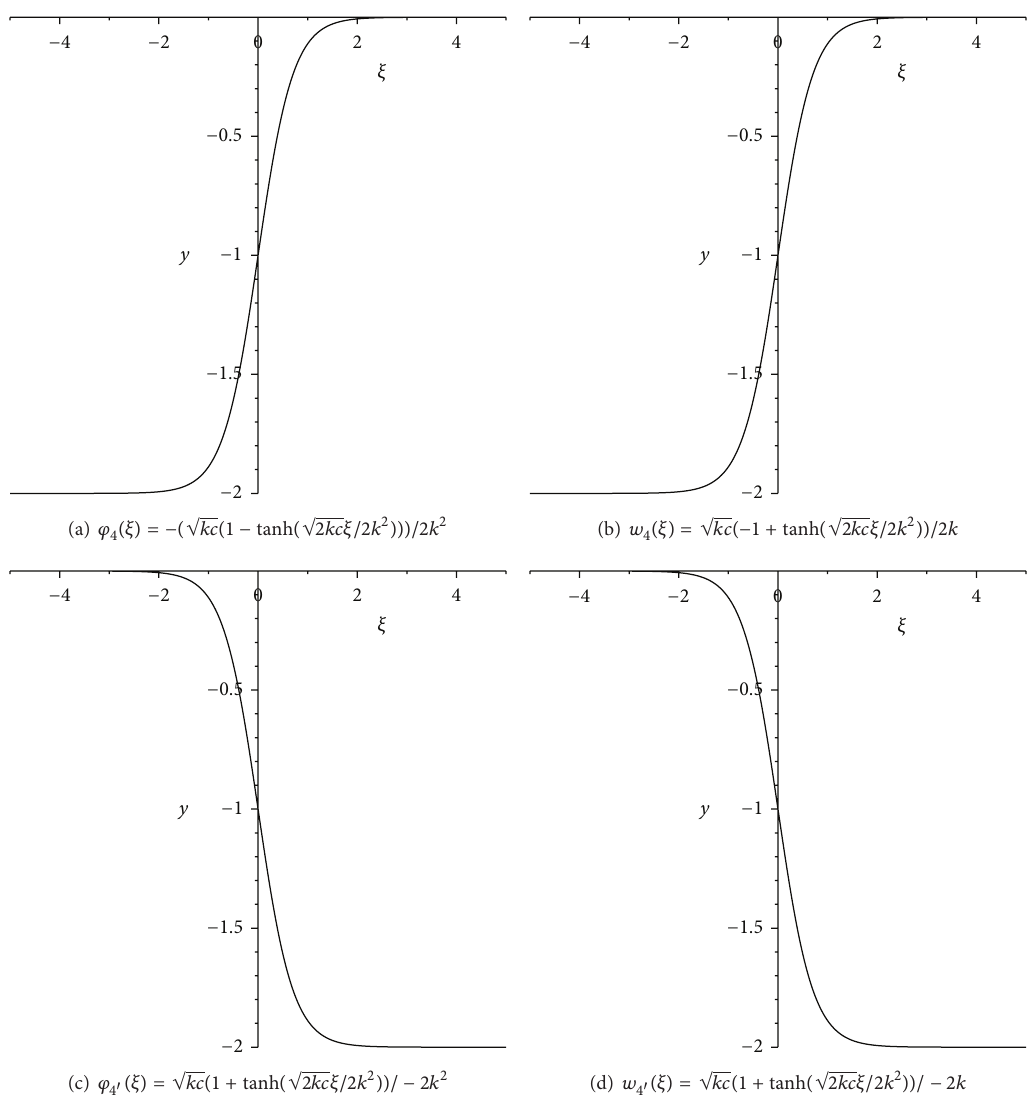
Figure 7: The kink (antikink) wave solutions of the system (11) and the system (3) when 𝑟 = −2√𝑘𝑐 , 𝑘 > 0 , 𝑐 > 0 , and Δ ≥ 0 .